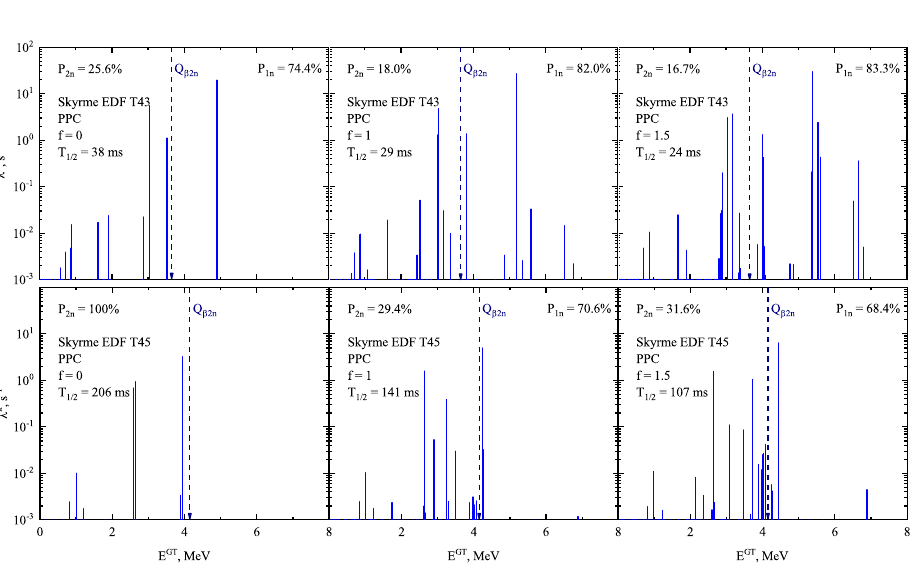
Figure 2. (Color online) The β -decay rates of 132 Cd calculated with Skyrme EDF’s T43 (upper panels) and T45 (lower panels). The strength of parameter of f is varied from 0 to 1.5. The neutron-emission window Q β 2 n is denoted by dashed